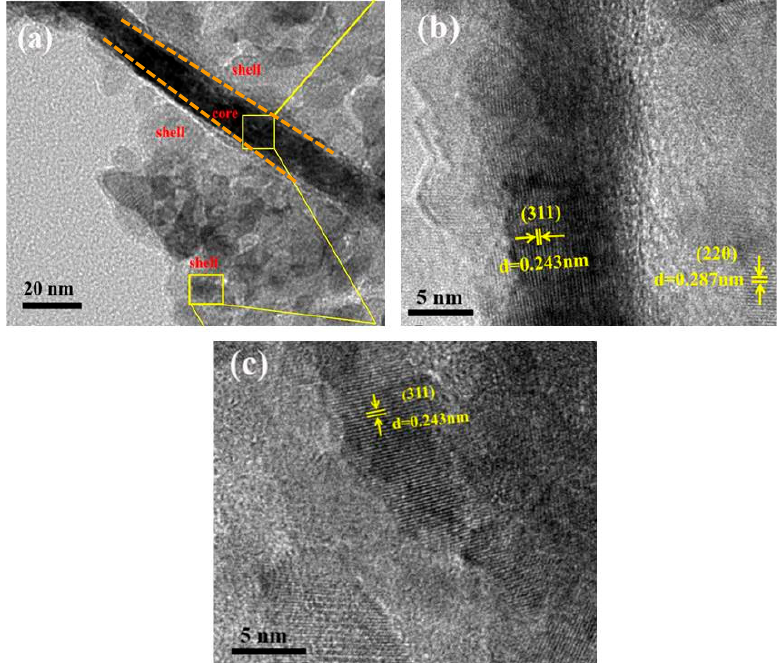
Figure 4. ( a ) TEM images and ( b , c ) HRTEM images of the core-shell NiCo 2 O 4 @NiCo 2 O 4 /NF com- posite.